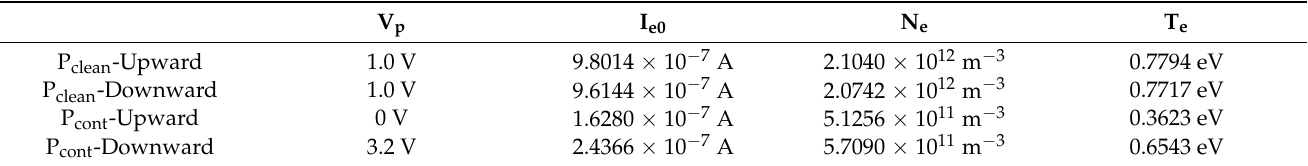
Table 1. The comparison of plasma parameters from P clean and P cont . V p I e0 N e T